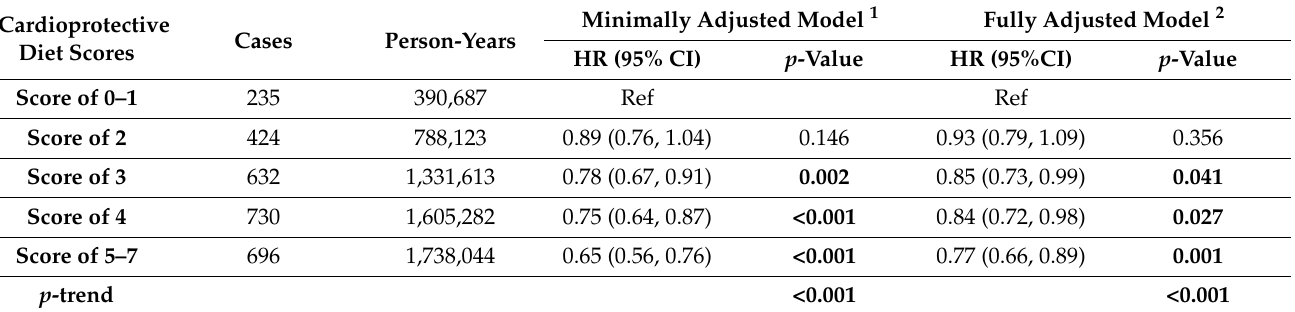
Table 2. Association between cardioprotective diet scores and risk of inflammatory bowel disease in multivariable models.